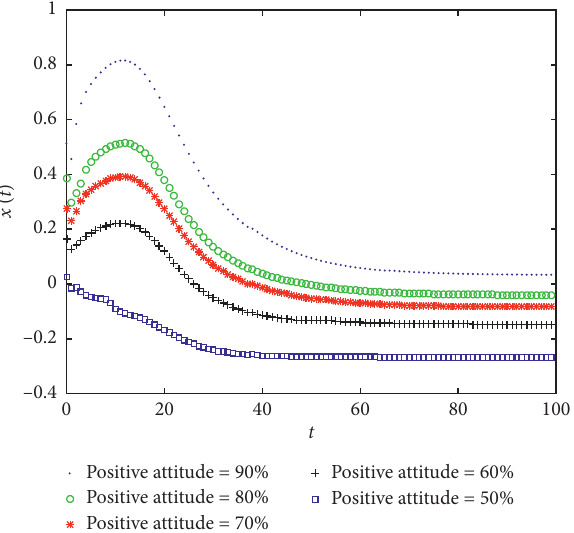
Figure 9: Impact of the proportion of group opinions’ tendency on average collective